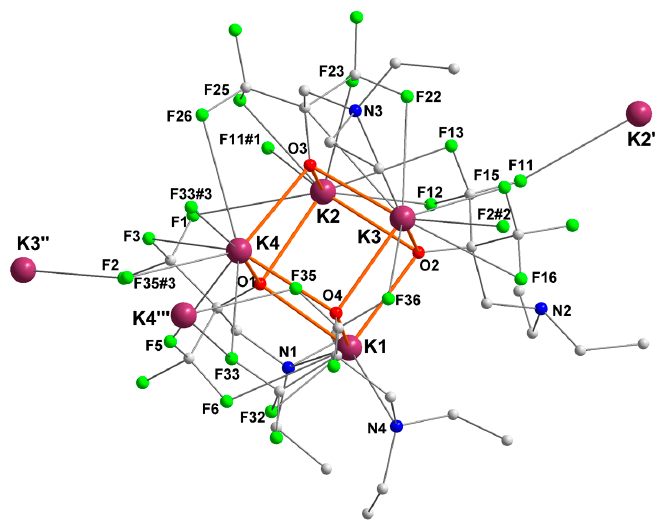
Figure 5. Representation of the molecular solid-state structure of the potassium complex [{RO 4 }K] 4 ([ 4 ] 4 ). Only the main component of disordered ethyl groups is depicted. Color code: purple, K; green, F; blue, N; red, O; grey, C. H atoms omitted for clarity.